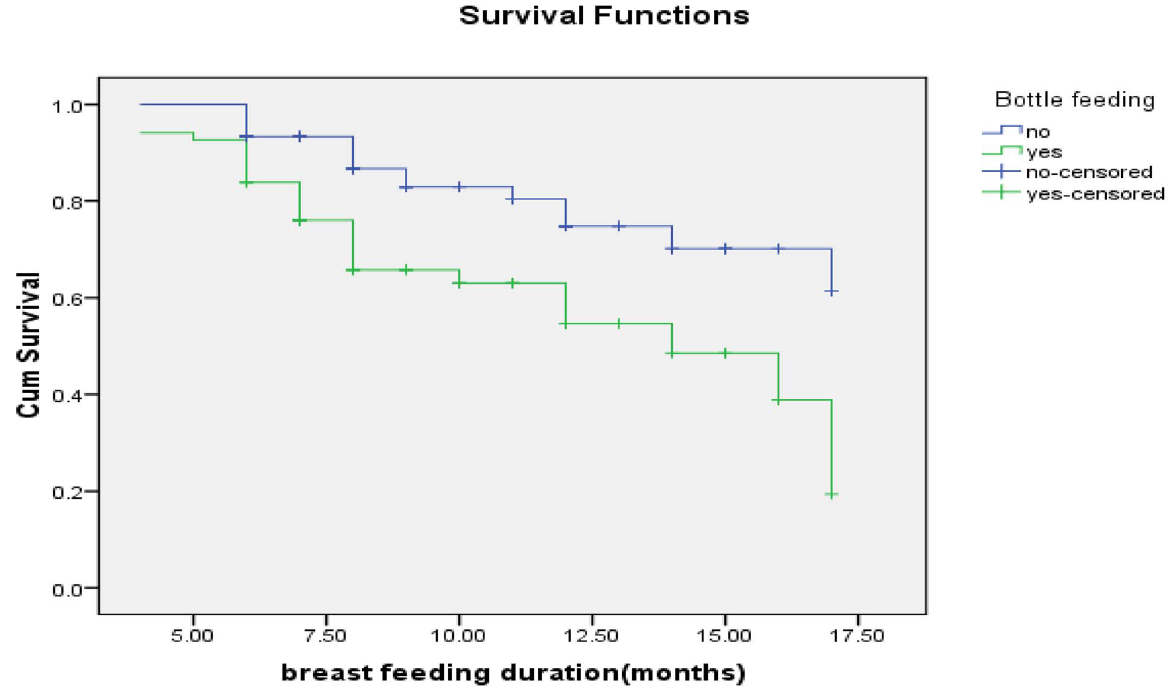
Figure 4. Survival function of breastfeeding duration stratified based on family size among HIV positive mothers in Sidama Zone, Southern Ethiopia,